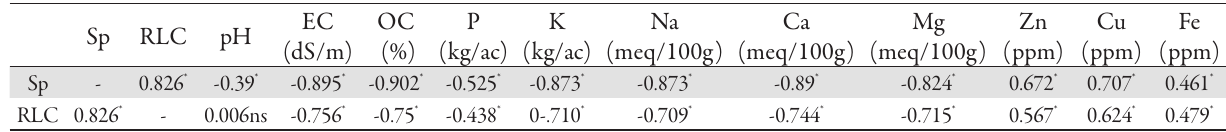
Tab. 5. Pearson correlation coefficient between spore density and AM root colonization with several soil chemical properties